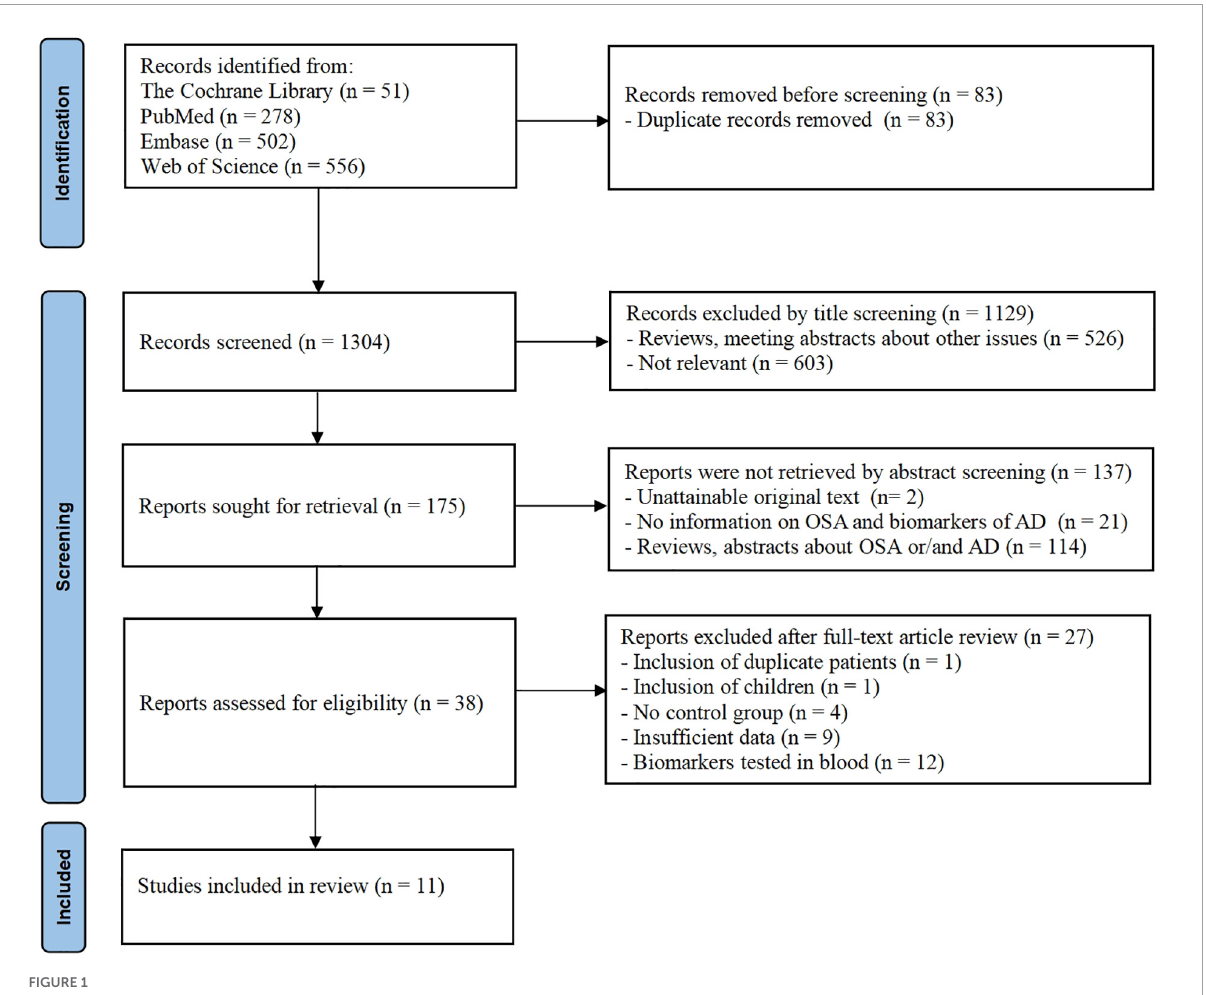
FIGURE1 Flowchart of search strategy and study